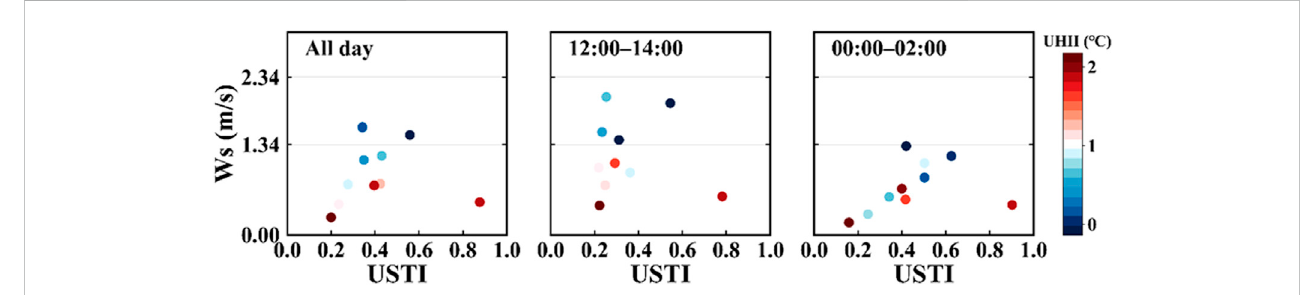
FIGURE 12 Relationship between USTI, wind speed (Ws), and UHII at each urban station (The dots in the fi gure represent each station and darker blue(red) dots indicate weaker(stronger)